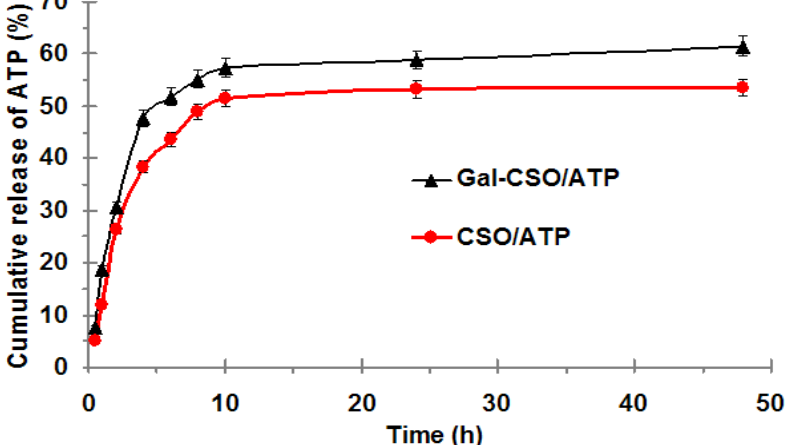
Figure 4. In vitro drug release profiles of Gal-CSO/ATP and CSO/ATP nanoparticles in PBS (pH 7.4) at 37 °C. Data represent the mean ± standard deviation ( n =